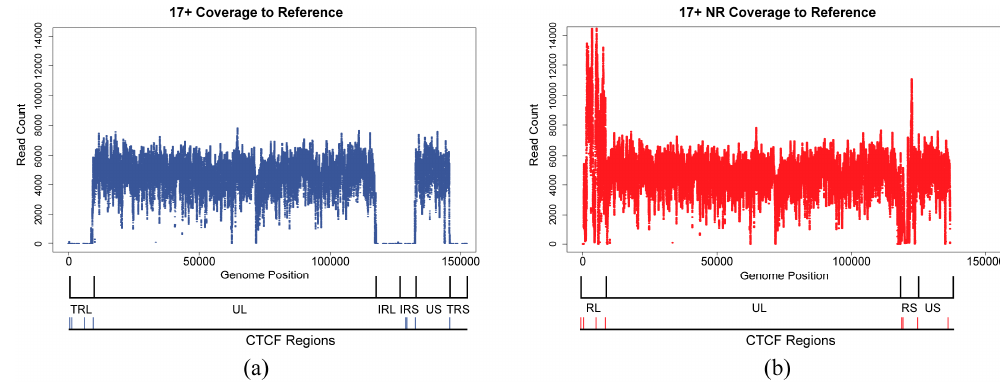
Figure 5. Coverage plots of reads aligning uniquely to the full-length HSV1 reference and the NR-reference. ( a ) The number of reads that aligned uniquely to all positions in the full-length HSV1 genome is on the y -axis (range from 0 to 10,307 with a median of 7548), while the genome position is on the x -axis. Genomic features are indicated under the plot including locations of CTCF motif clusters. Drops in alignment coverage for uniquely mapping reads are expected in the regions corresponding to the repeat regions. ( b ) The number of reads that aligned uniquely to all positions in the HSV1 NR-reference is on the y -axis (range from 0 to 17,324 with a median of 7597), and the genome is on the x -axis. Coverage is maintained in the representative repeat region. Genomic features are indicated as in ( a ).